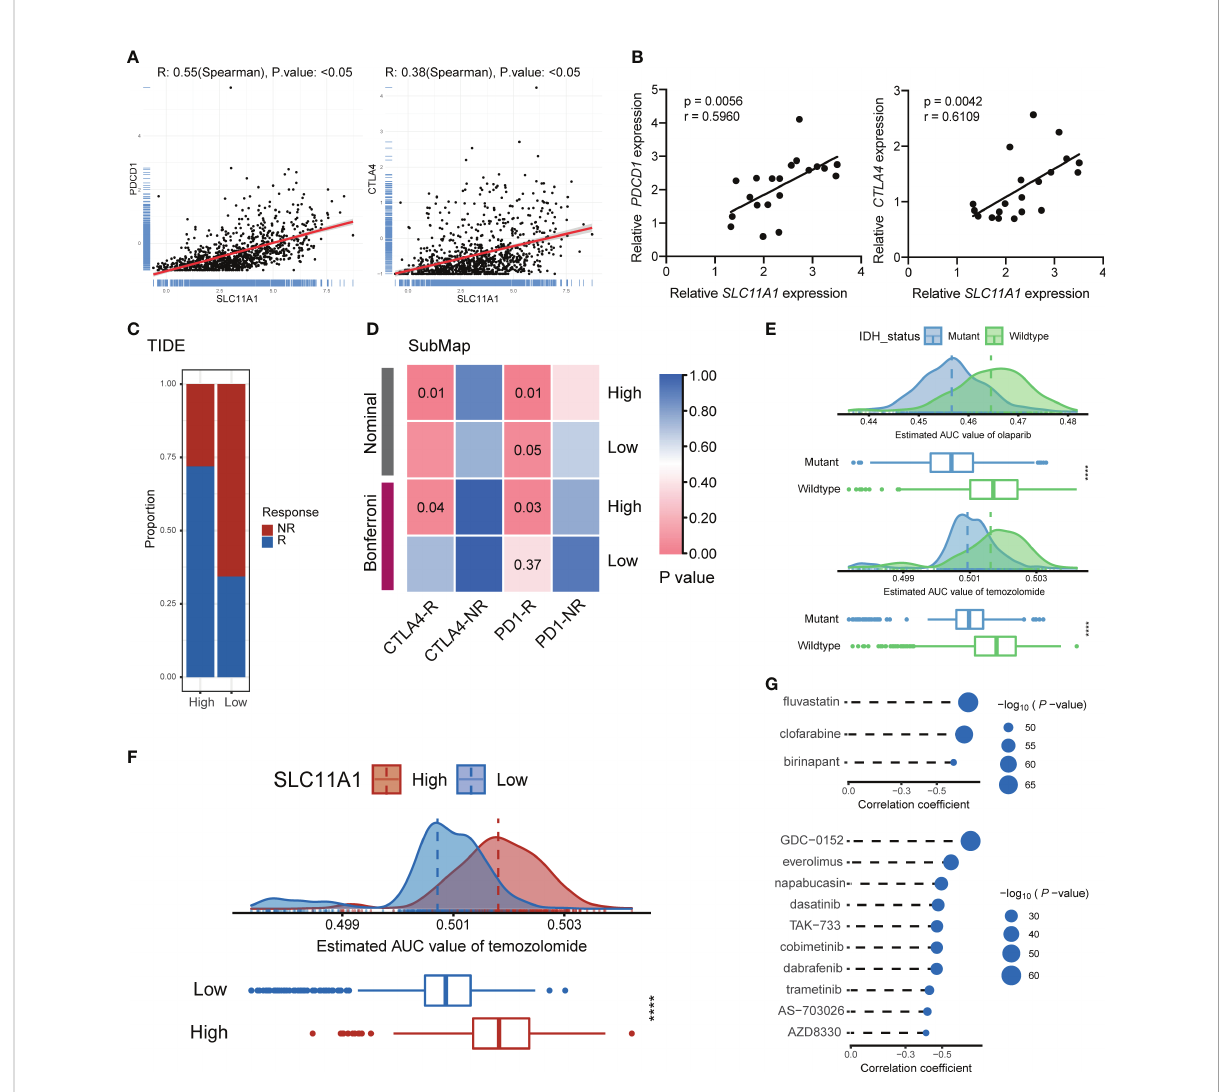
FIGURE 7 Subgroup divided by SLC11A1 predict potential immunotherapy responses of gliomas and identi fi cation of candidate agents with higher drug sensitivity in glioma patients. (E) Comparison of estimated olaparib (up) and temozolomide ’ s (down) sensitivity (logAUC) between IDH mutant and wildtype groups. (F) Comparison of estimated temozolomide ’ s sensitivity (logAUC) between high-SLC11A1 and low-SLC11A1 groups. (G) Spearman ’ s correlation analysis of three CTRP-derived compounds (up) and ten PRISM-derived compounds